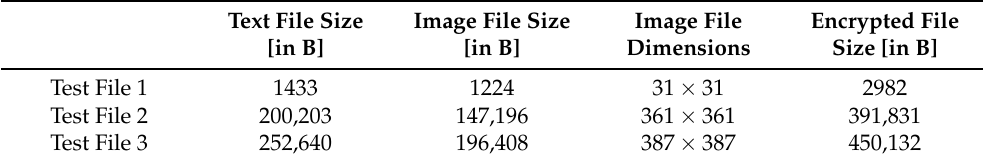
Table 1. Disk space comparison of the original text file with its image version and the encrypted image.